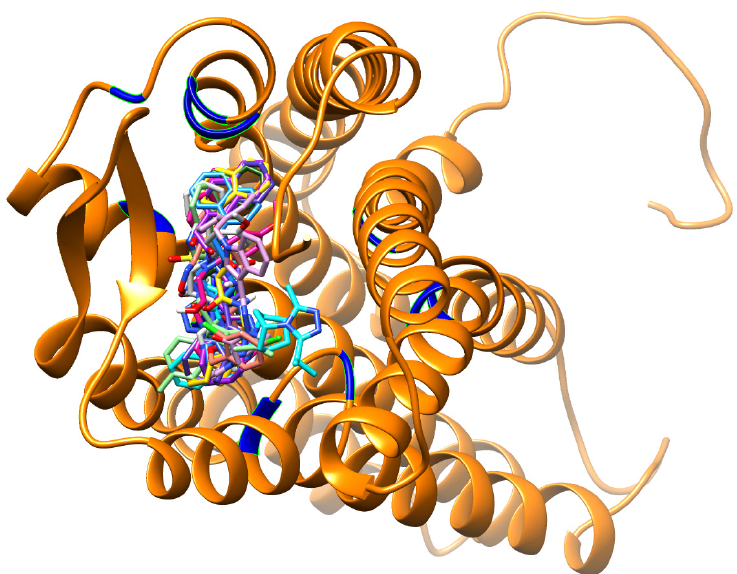
Figure 7. Docking conformations of the known CCR5 antagonist (maraviroc) and the top 10 ranked docked compounds from both the pharmacophore-based and structure-based libraries determined in this study, all-complexed with the CCR5